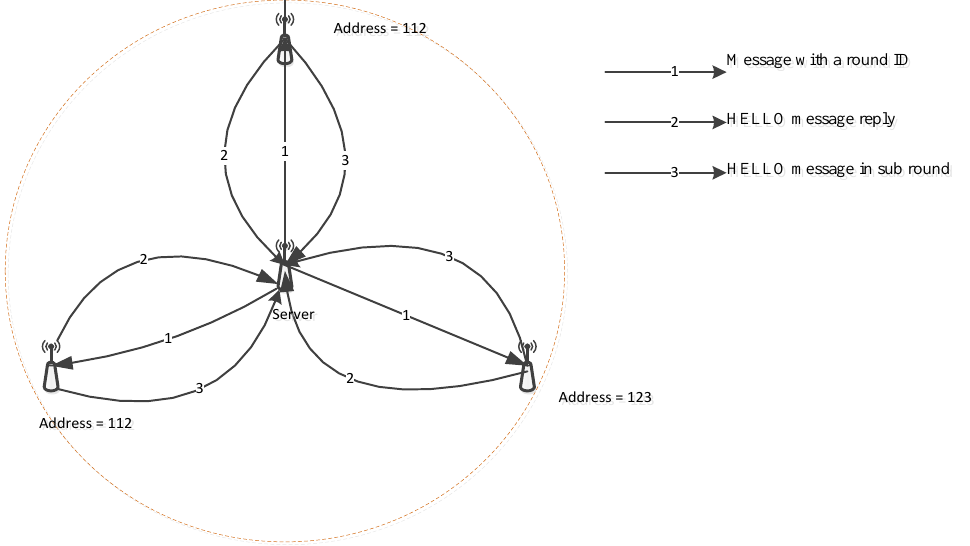
Figure 7. An addressing scheme and possible duplicate.